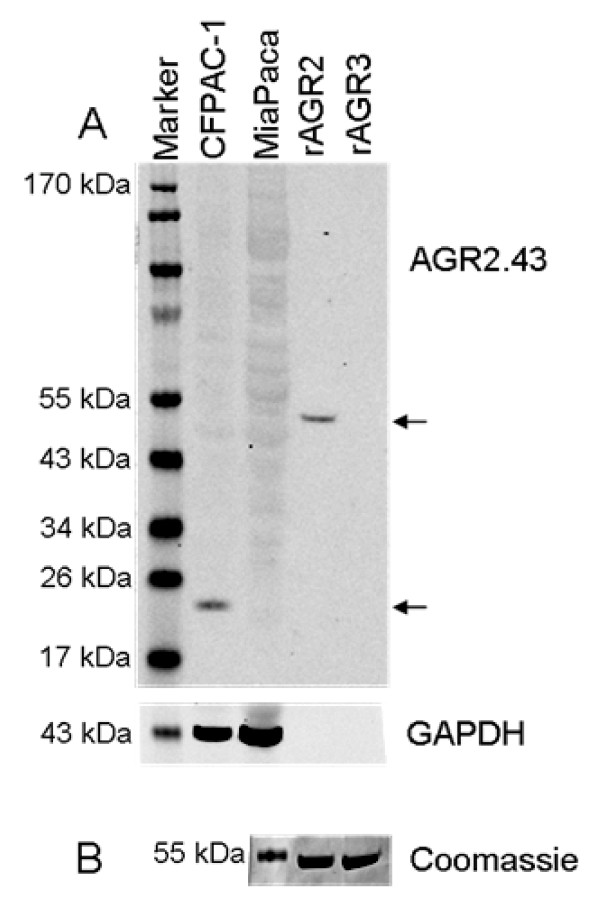
Detection of AGR2 by Western blot with mAb AGR2.43. A, Western blot of lysates from the human pancreatic cancer cell lines CFPAC-1 and MiaPaca, recombinant GST-tagged AGR2 (rAGR2) and AGR3 (rAGR3). As expected, mAb AGR2.43 detected the AGR2 protein (20 kDa) in CFPAC-1, but not MiaPaca lysates. The mAb also detected rAGR2 (45 kDa) but not rAGR3 (45 kDa). Note that rAGR2 and rAGR3 are of a higher molecular weight than their native counterparts because they carry a GST tag. B, Coomassie stained gel showing equivalent loading (1 μg each) of GST-tagged rAGR2 and rAGR3 proteins.